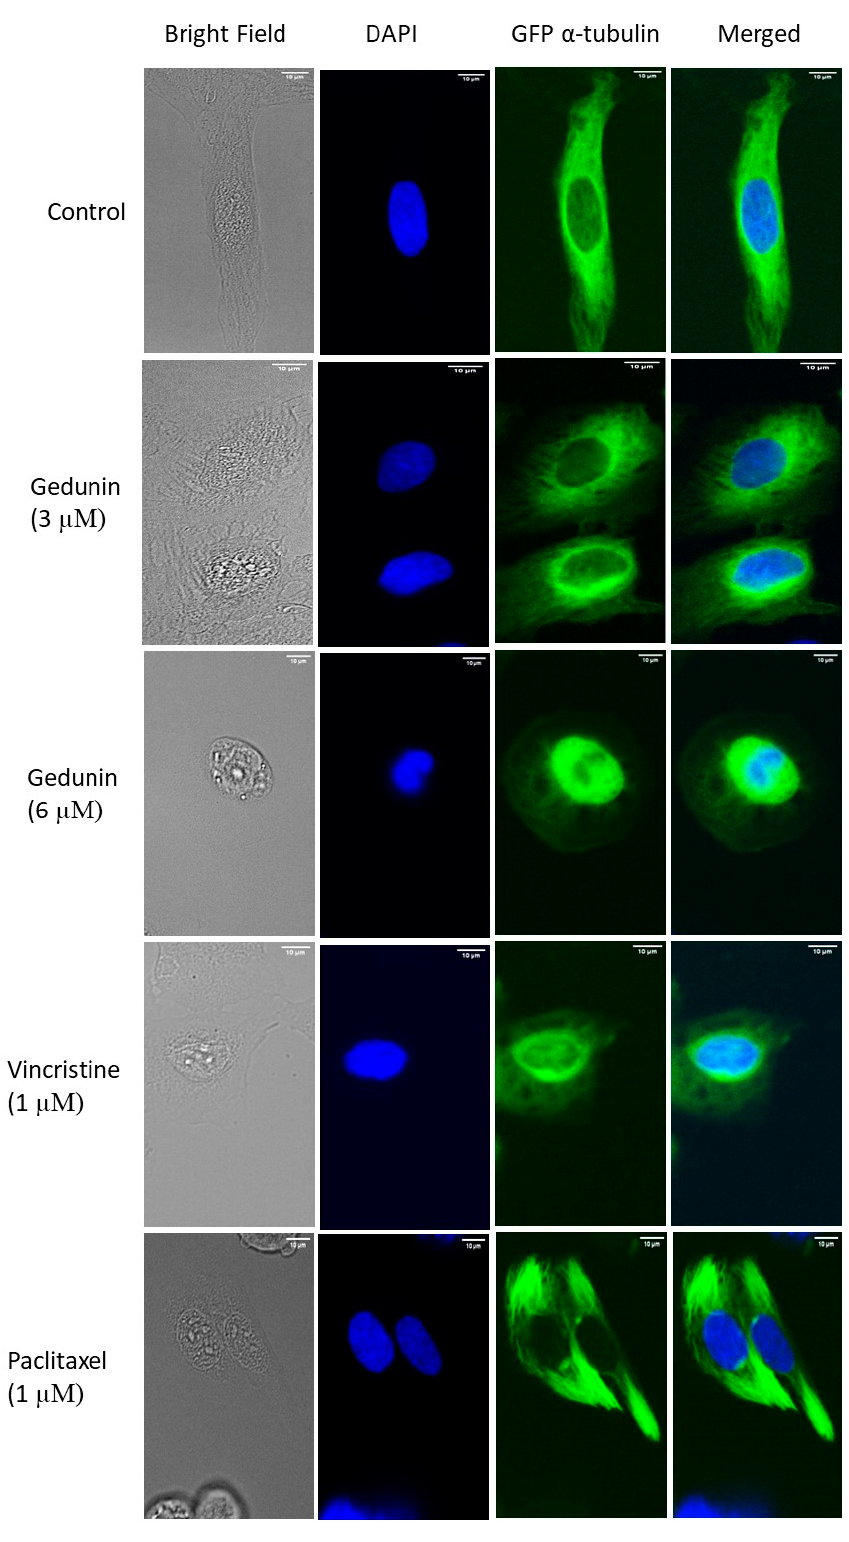
Figure 6. Disruption of the microtubule network in gedunin-treated U2OS cells. Micrographs of fixed U2OS cells were taken after 24 h of treatment with DMSO, various gedunin concentrations, vincristine, and paclitaxel. The microtubules were imaged at 40× magnification using an AF7000 widefield fluorescence microscope (scale bars = 10 µ m). The images were merged with DAPI (blue) to represent the